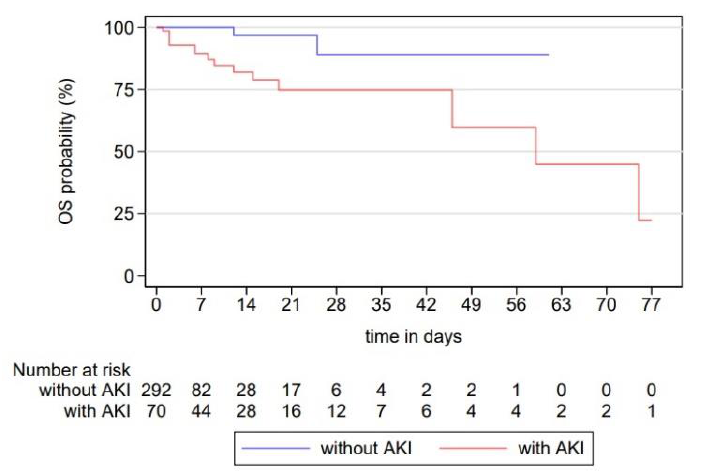
Figure 2. Kaplan–Meier analysis of survival in patients with and without postoperative acute kidney injury. Survival analysis showed statistically significant difference in survival between two groups (Log Rank test, p < 0.001), displaying a significantly higher probability of death for patients with AKI at any time point. Table 6. Univariate and multivariate Cox regression according to postoperative Acute Kidney Injury development.